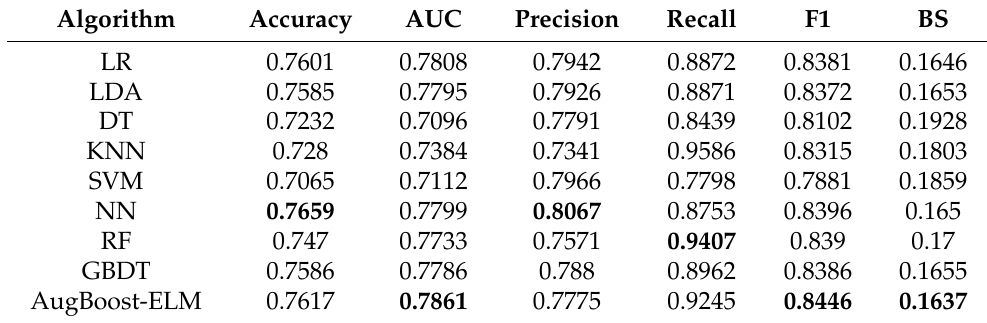
Table 5. Performance comparison of credit scoring models for the German dataset.